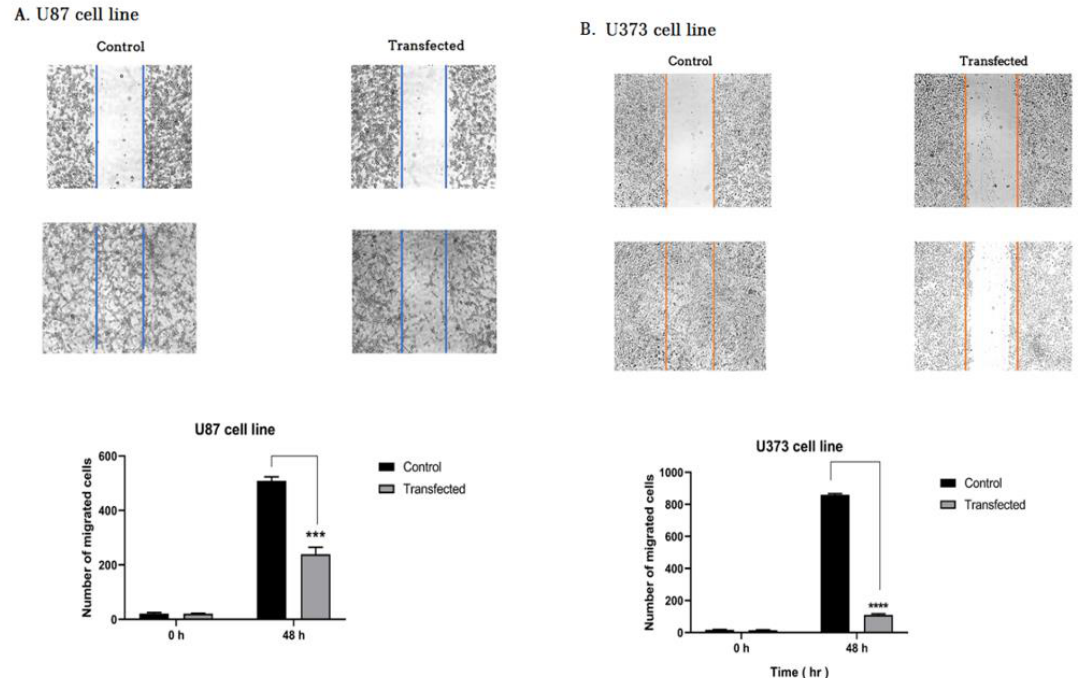
Figure 8. Our results showed that ZEB2 suppression attenuated the migration of glioblastoma cells. ( A , B ) Wound scratch assay showing that non-transfected cells (control group) have a significantly greater migratory ability than transfected glioblastoma cells with ZEB2-specific siRNA. The bar graph represents the quantity of migrated cells per field (*** p < 0.001, **** p < 0.0001).